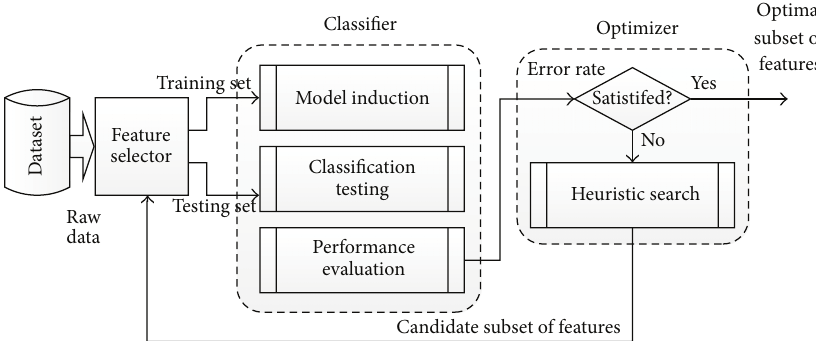
Figure 2: Process model of the proposed swarm